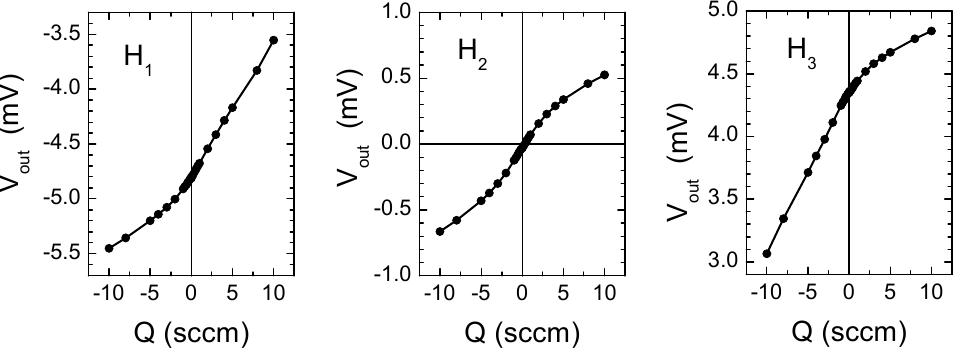
Figure 8. Response to nitrogen flow rate of a triple heater sensor with only one heater powered at a time. The powered heater is indicated in the plots.